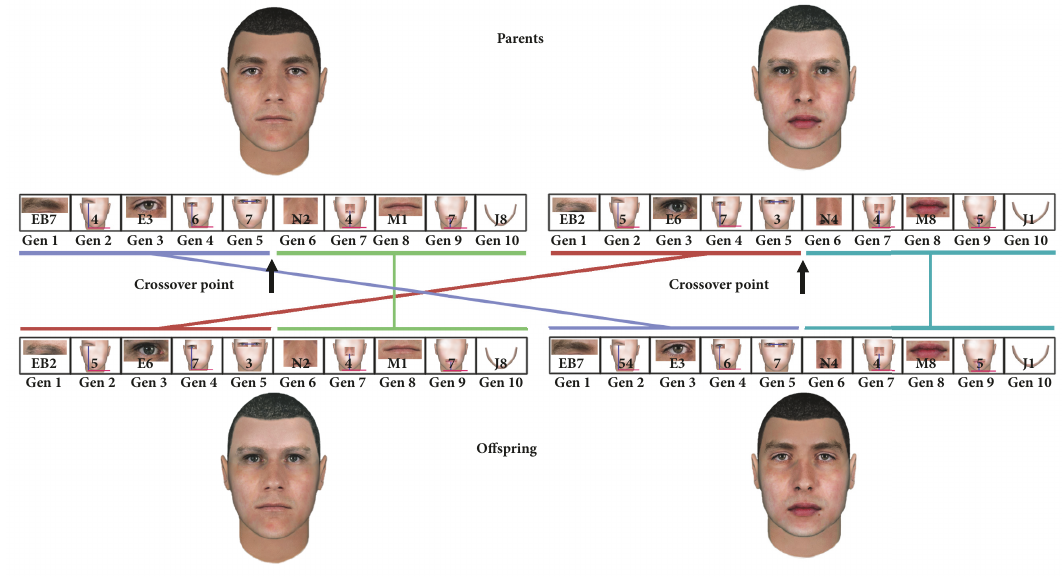
Figure 3:Single-pointcrossoverprocess. Offspring is obtained by merging thegenes on eachside of thecrossoverpointin eachof the parents.